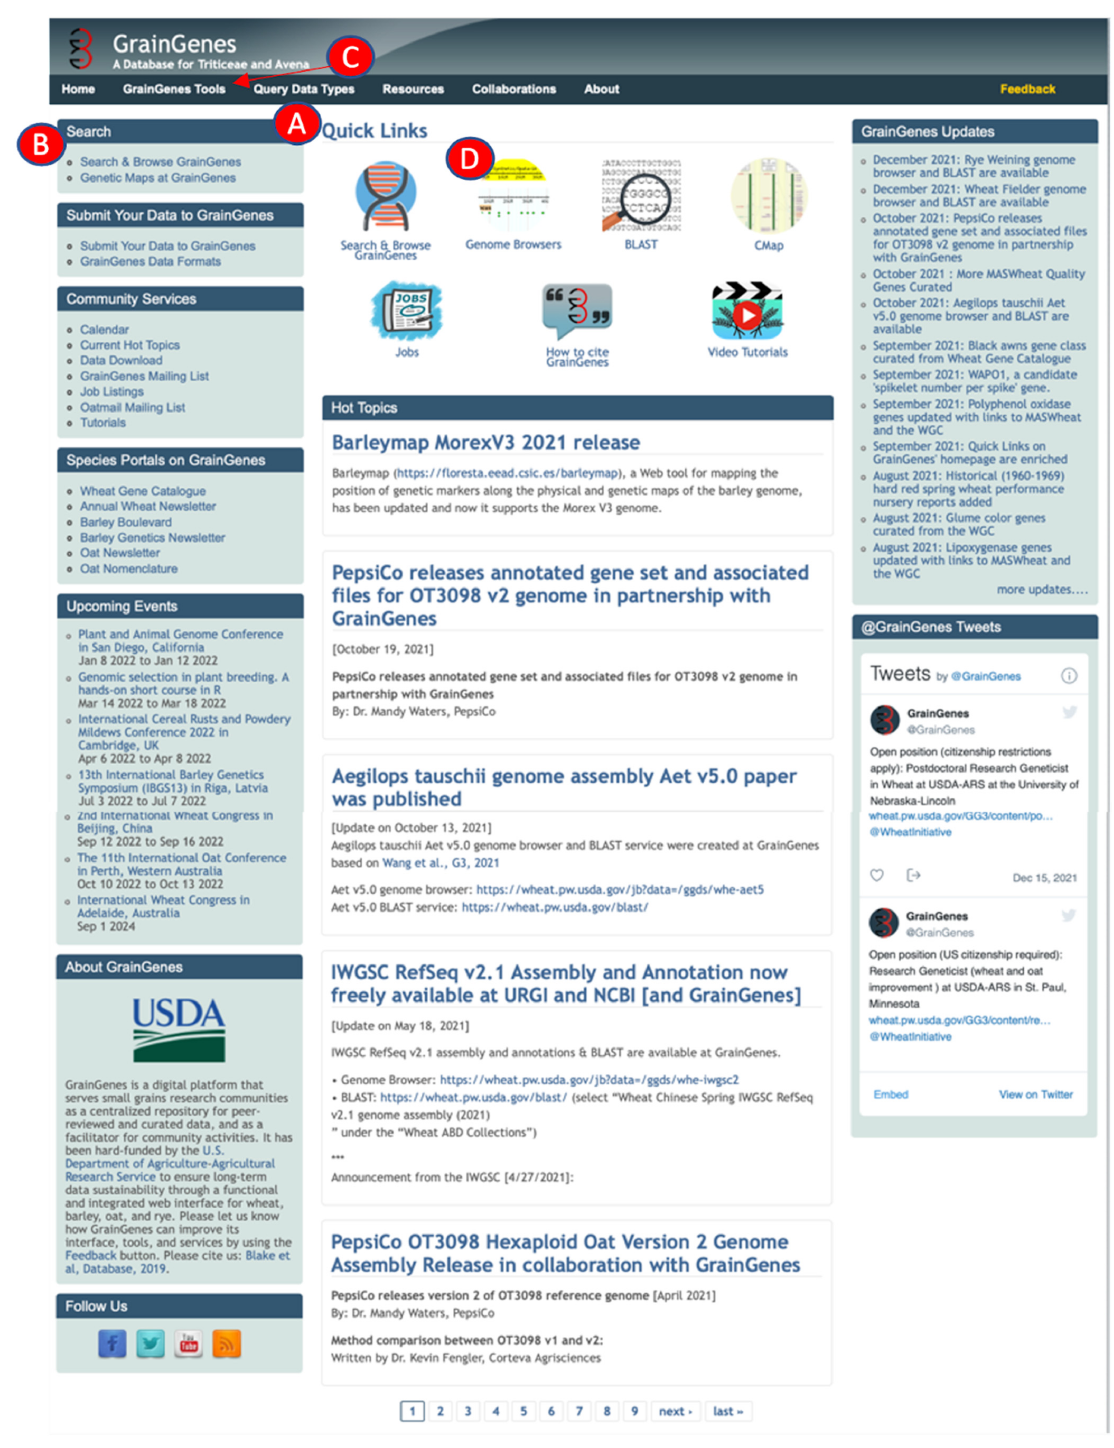
Figure 1. The GrainGenes homepage in January 2022. Highlighted features are ( A ) Quick Links for the most popular features; ( B ) One of three ‘Search and Browse’ portals; ( C ) Menu for advanced search tools; and ( D ) Genome Browser collection.